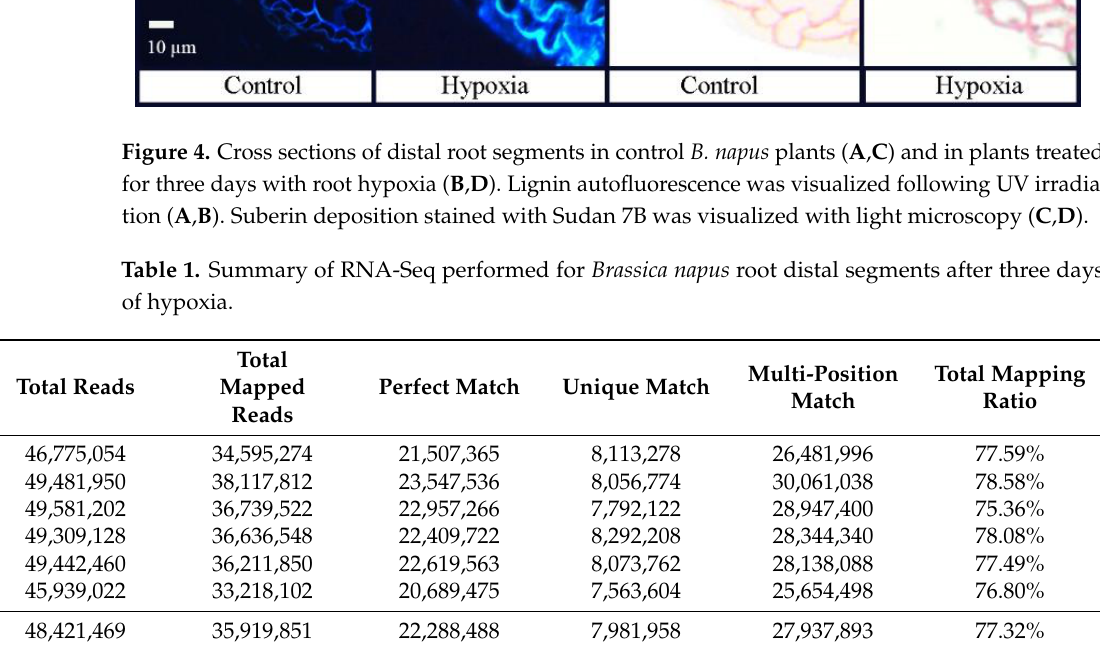
Table 1. Summary of RNA-Seq performed for Brassica napus root distal segments after three days of hypoxia .